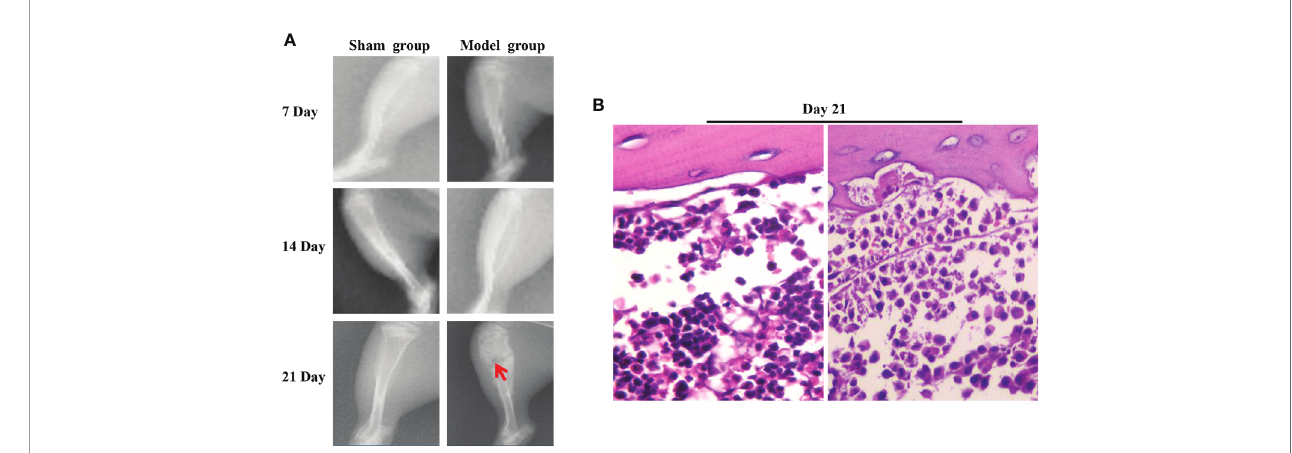
FIGURE 3 | The results of X-ray and H&E of tibia of CIBP rats. (A) On the 7, 14, 21st day the X-ray results of tibia in the sham and model groups indicated that the arrow pointed to the site of tibia destruction. It was found that the tibial structure of the model group was signi fi cantly damaged, whereas the local bone density was uneven, with loss of cortical bone defect, swelling of surrounding muscles and soft tissues. However, in the Sham group, no abnormalities were noted in the tibia, the bone density was uniform, and the cortical bone was continuous. No deletion was present. (B) H&E results of tibia in the sham group and the model group (400×). The results indicated that the bone marrow cavity of the model group was fi lled with a large number of tumor cells, the trabecular bone was destroyed, the bone structure was seriously lost and the surrounding muscle and soft tissues were destroyed by the tumor cells. Various normal bone marrow cells were observed in the bone marrow cavity of the sham group and the trabecular and cortical bones were intact without any obvious